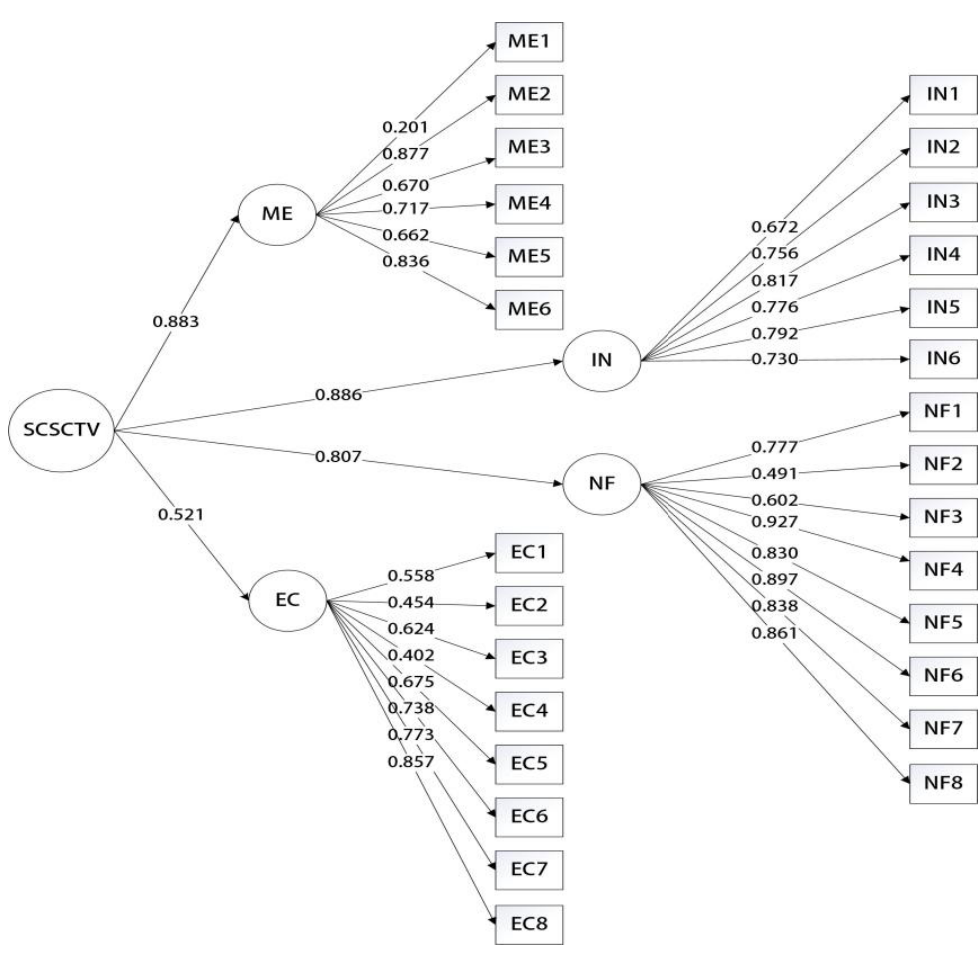
Figure 5. Factor loadings of the four-factor SCSCTV with 24 items. 4.3. Results of Method 2 4.3.1. Qualitative Analysis As all the statements are positive descriptions, higher scores reflected higher levels of participants’ feelings for SOC. However, for items ME1, NF2, NF3, EC1, EC2, and